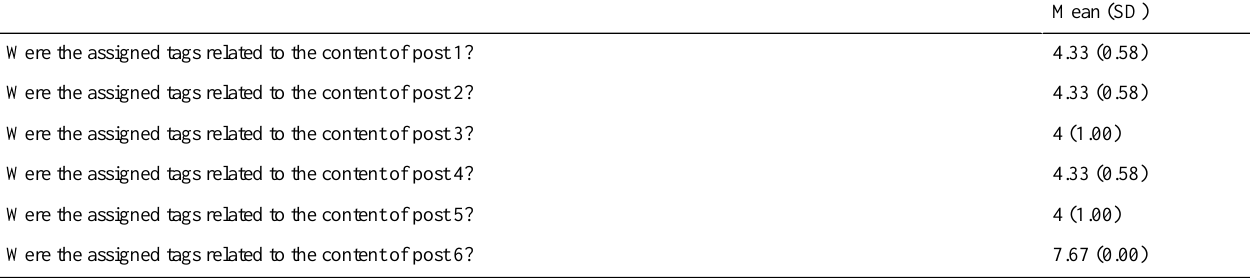
Table 12. Relatedness of the most commonly used tags to the aggregated gastroenterology